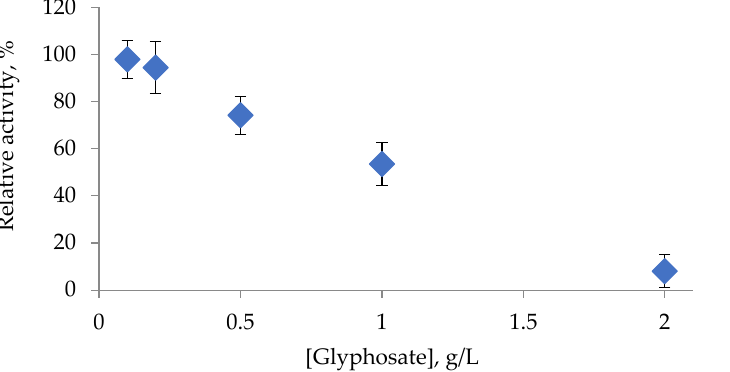
Figure 3. Relative activity of trypsin in the presence of glyphosate. The amount of trypsin in the reaction mixture was 11 U. The values of IC 20 and IC 50 for glyphosate were determined as 0.5 and 1 g/L,